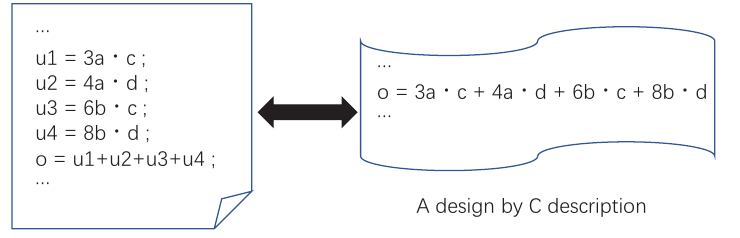
Figure 6. A simple example of a high-level design.